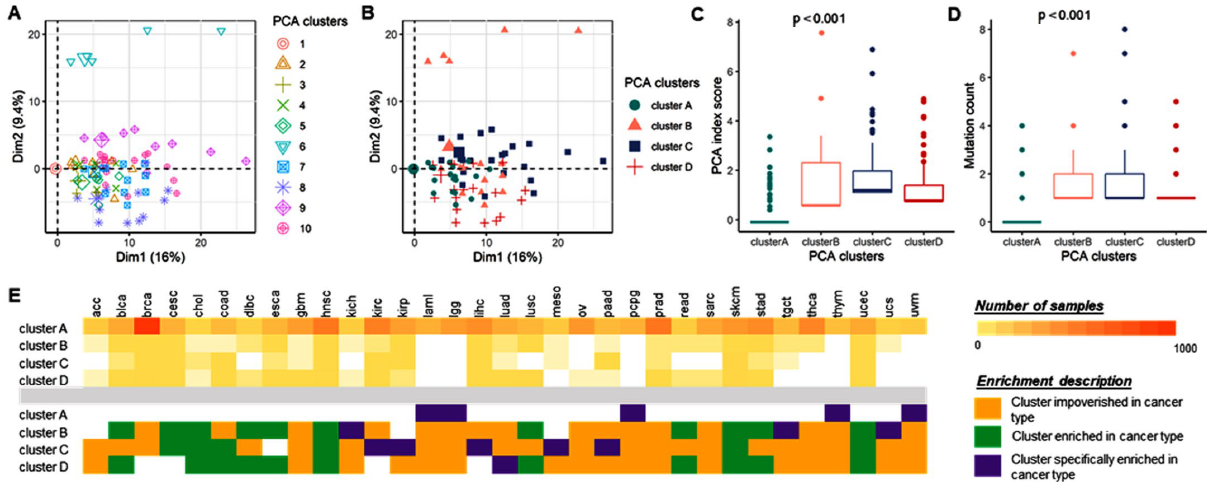
Figure 11. Four pan-cancer clusters of samples extract tumors with poor outcomes. ( A , B ) Principal Component Analysis of the pan-cancer study with the samples clustered in 10 distinct clusters ( A ), from the original hierarchical HCPC R function, and four clusters ( B ), following an optimized reduction. ( C , D ) PCA index score ( C ) and mutation count ( D ) distribution across the four clusters. Kruskal test p-value. ( E ) Contingency table of the four clusters across the cancer types (top table) with corresponding description of cancer type impoverishment (orange) or enrichment (green) in each cluster (table bottom). Purple highlights cancer types presenting a specific enrichment in one cluster.